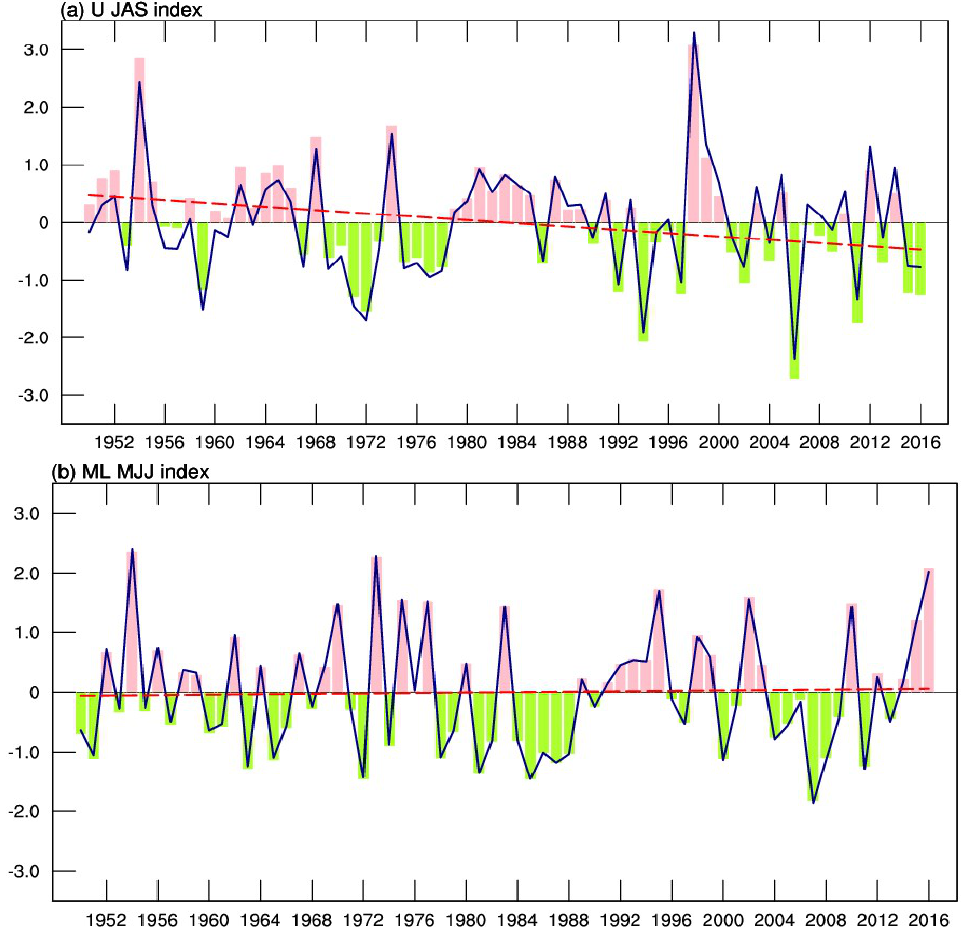
Figure 3. Time series of normalized observed runoff (bars) and detrended runoff (blue curves) in each concentration period at the ( a ) upper (U) and ( b ) mid-lower (ML) reaches of the YR, respectively. Red lines represent the trend. In this study, MJJ means May–June–July and JAS means July–August–September.